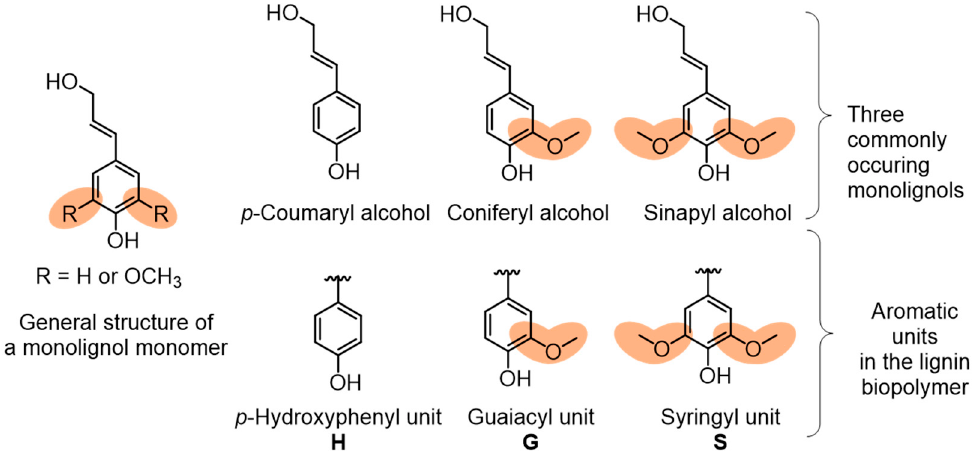
Figure 2. Monolignol building blocks and the resulting aromatic units present in lignin.